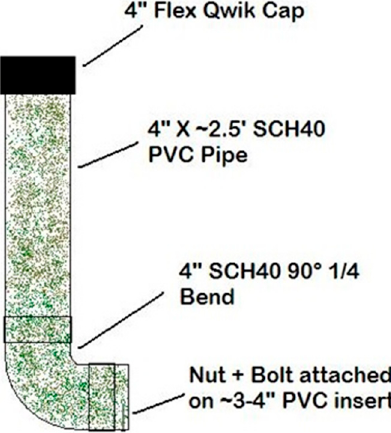
Figure 3. A USDA WS oral rabies vaccination standard bait station.